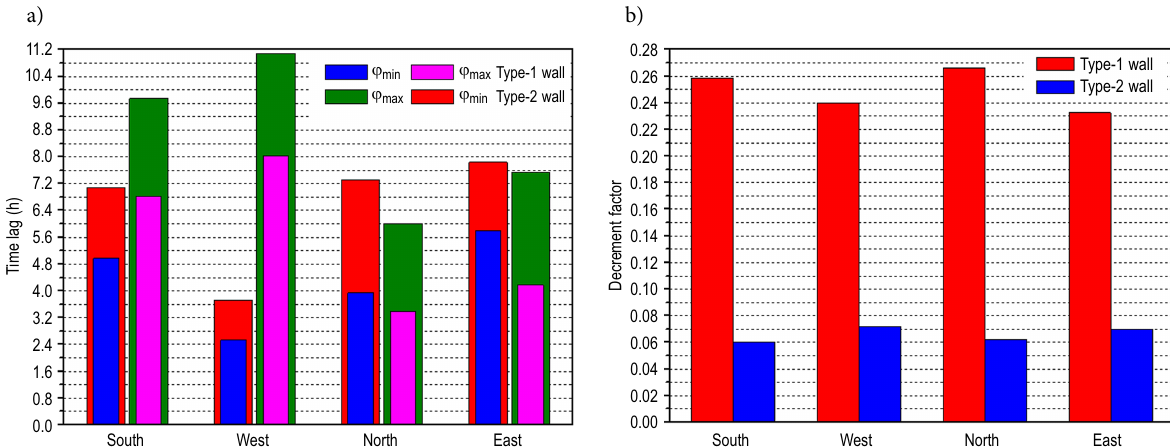
South North Fig. 14. Time lags φ and φ (a) and decrement factor f (b) for type-1 and type-2 walls for a typical summer day, 25 July 2008 max min